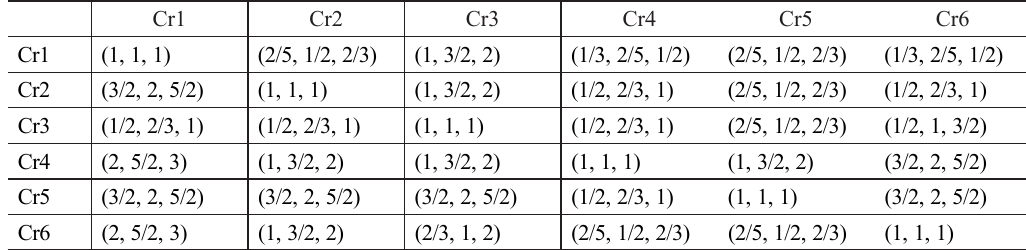
Table 3. The pairwise comparisons of criteria with related to goal with fuzzy